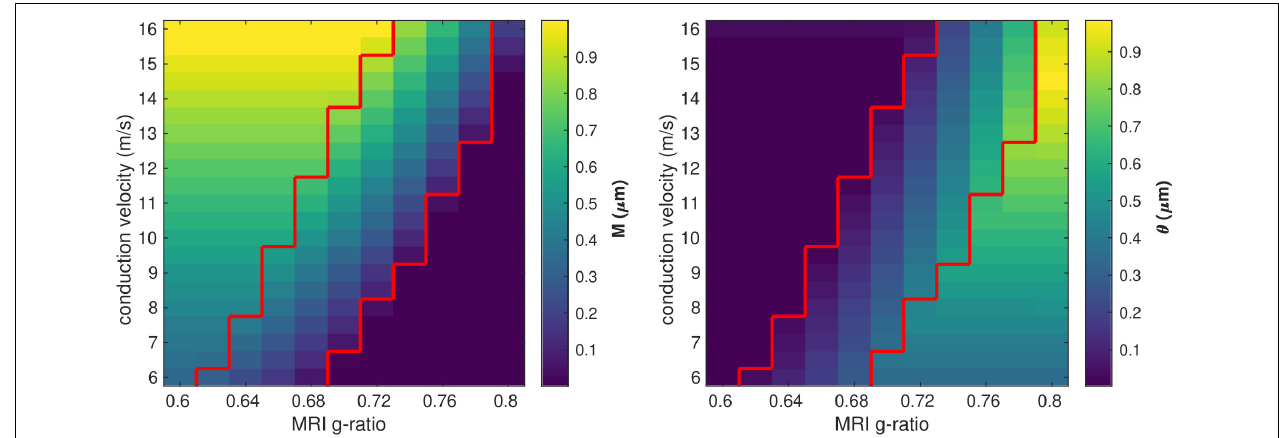
FIGURE 3 | Range of in vivo data compatible with the proposed model. Combinations of g MRI and V that lead to biologically plausible values of the model parameters (0.05 < M < 0.9 µ m and 0.01 < θ < 0.9 µ m) are located between the two red contour lines.